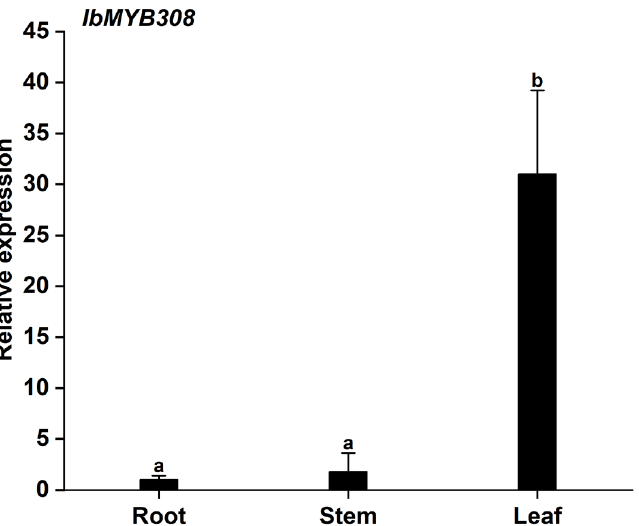
Figure 3. Expression of IbMYB308 in different tissues of sweet potato by qRT-PCR. Data represent the mean of three biological replicates ± SD ( n = 3 ). Error lines indicate standard deviations. Different lowercase letters (a, b) on the bars indicate significant differences at p < 0.01.